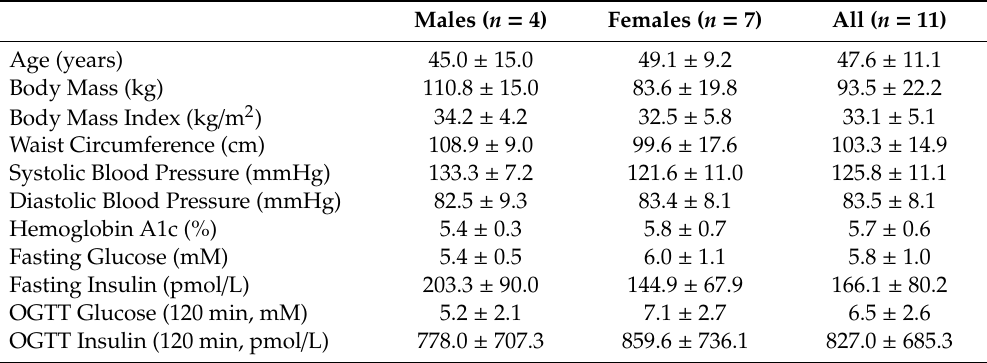
Table 1. Participant